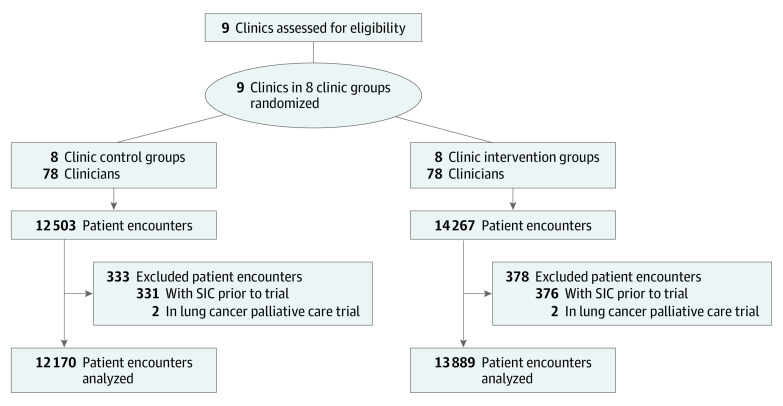
CONSORT DiagramSIC indicates serious illness conversation.